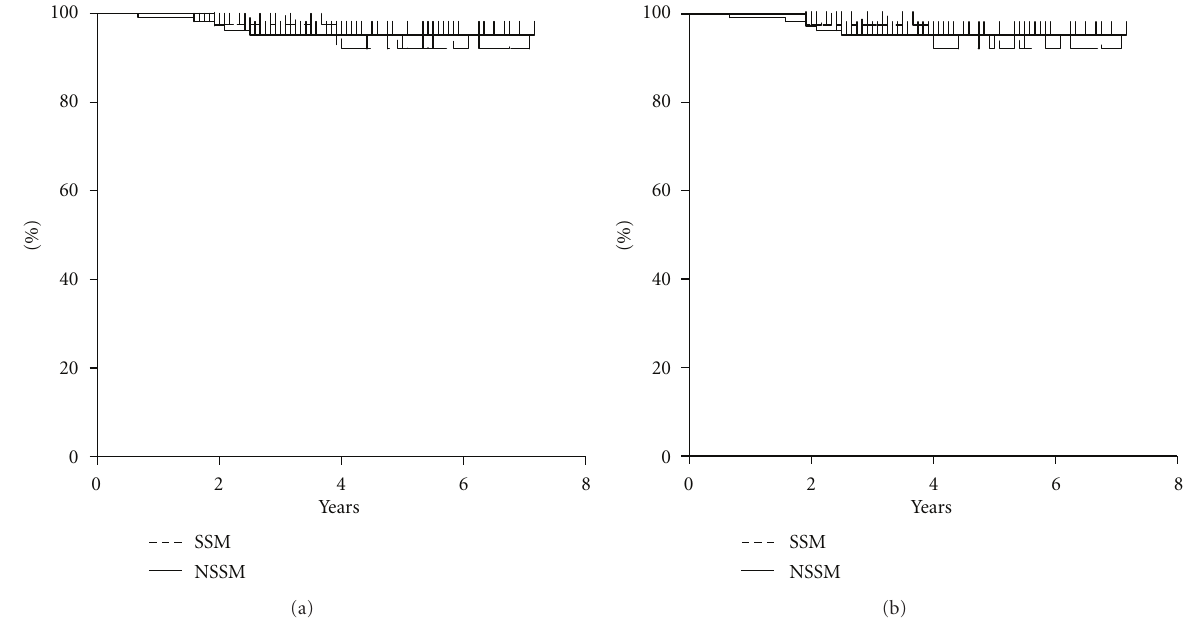
Figure 3: Kaplan-Meier survival curve for SSM and NSSM. (a) Local disease-free survival P = 0.75. (b) Overall survival P = 0.69.